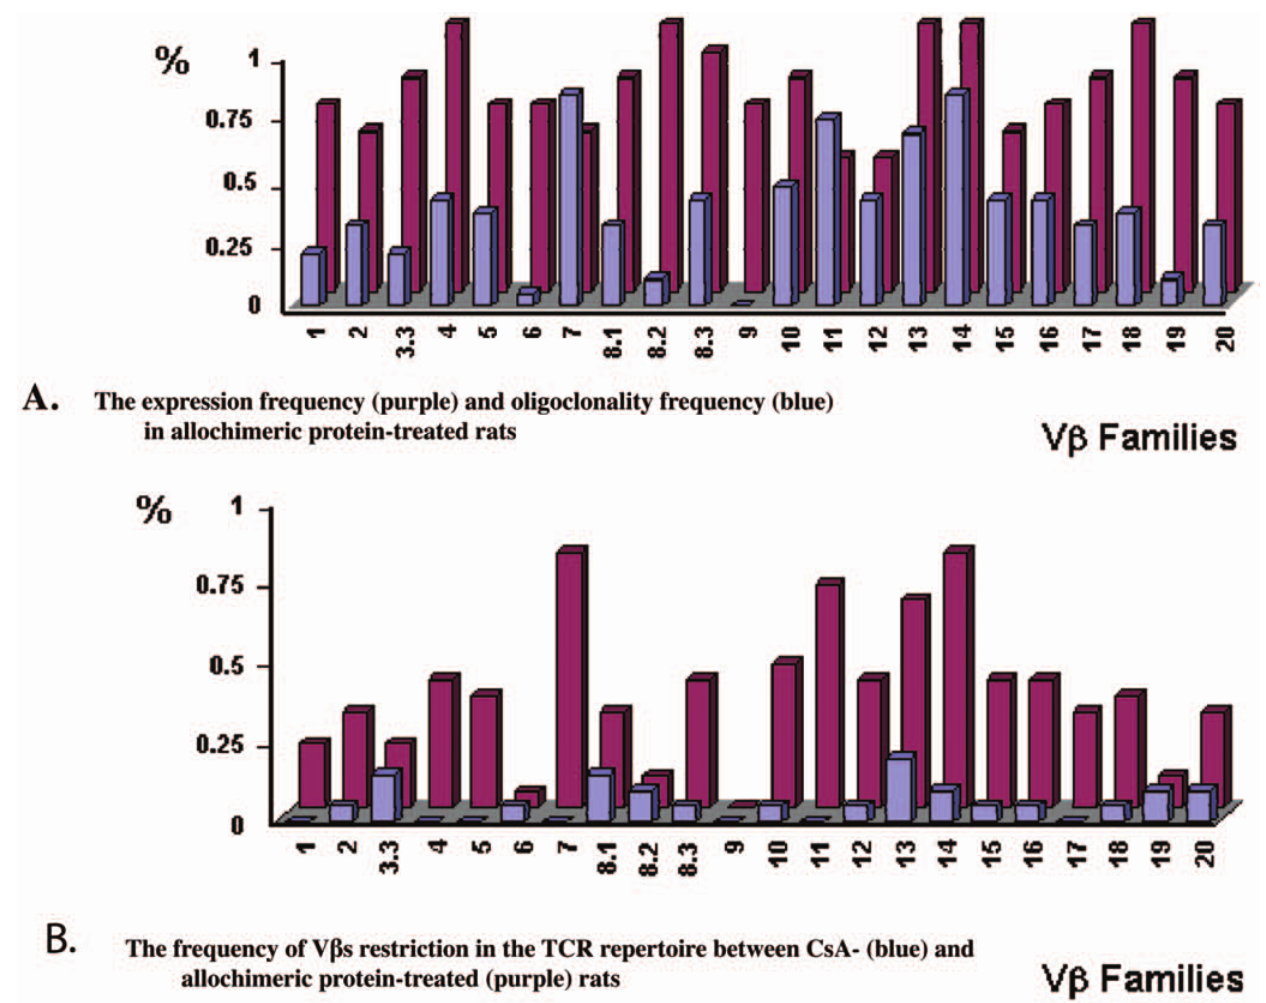
Figure 3. The frequency of oligoclonality and of Vbs expression in TCR repertoire in long-term ( . 100 days) tolerant CsA and allochimeric protein-treated, ACI recipients of WF cardiac allografts. The frequency of expression and oligoclonality for each Vb gene was calculated as a percentage of the total frequency of detection of each Vb in all (positive and negative) PCR amplification experiments. (b) There is significant difference between the frequency of Vbs restriction in the TCR repertoire between CsA- (blue) and allochimeric protein-treated (purple) rats. (a) There was no correlation between expression frequency (purple) and oligoclonality frequency (blue) in allochimeric protein-treated rats. Vb7, 11, 13, 14, 15 gene products show 1-3 dominant peaks, indicating TCR restriction in the T cell repertoire in allochimeric protein-induced tolerant rats. (A)